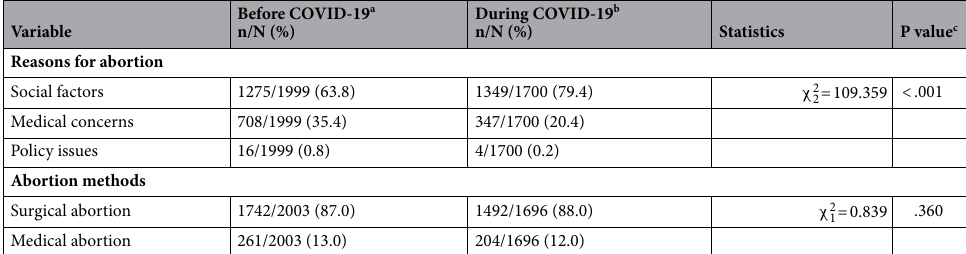
Table 4. Reasons for abortion and the choice of abortion methods before and during COVID-19 lockdown. a n = number who answered the question; denominator is not always 2054 because of missing data. b n = number who answered the question; denominator is not always 1735 because of missing data. c Two-tailed χ 2 analysis conducted for significance